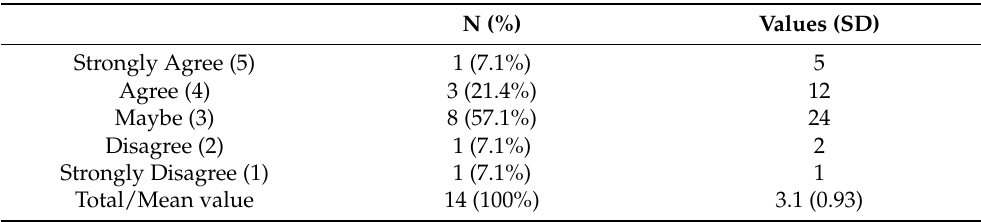
Table 7. Respondents’ Perceptions: are desalination plants the solution to the water scarcity issues in Mykonos (Q12).